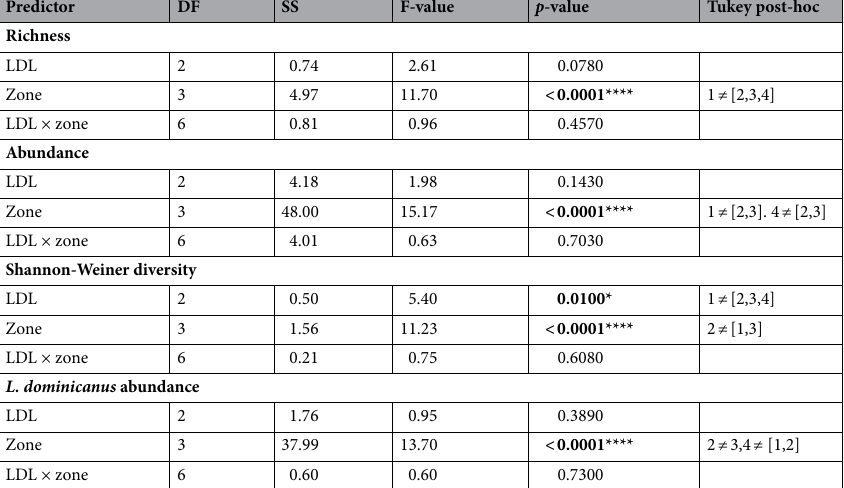
Table 4. Results of ANOVA testing effects of lockdown levels (LDL), zones and their interaction on shorebird assemblage metrics (richness, abundance, Shannon-Weiner diversity) and abundance of Kelp gull ( Larus dominicanus ) in Muizenberg beach. Significant p -values are shown in bold ( p < 0.05*, p < 0.001***). Results of post-hoc Tukey tests are shown in the far right column in cases where significant predictor effects were detected. Data from 2020, lockdown levels 3-1, were used in the